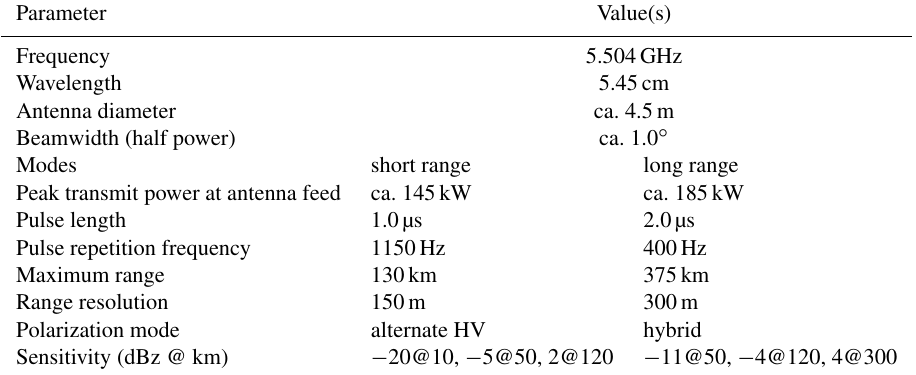
Table 1. Technical specifications of Poldirad. Note the different settings for the long-range and short-range modes. Parameter